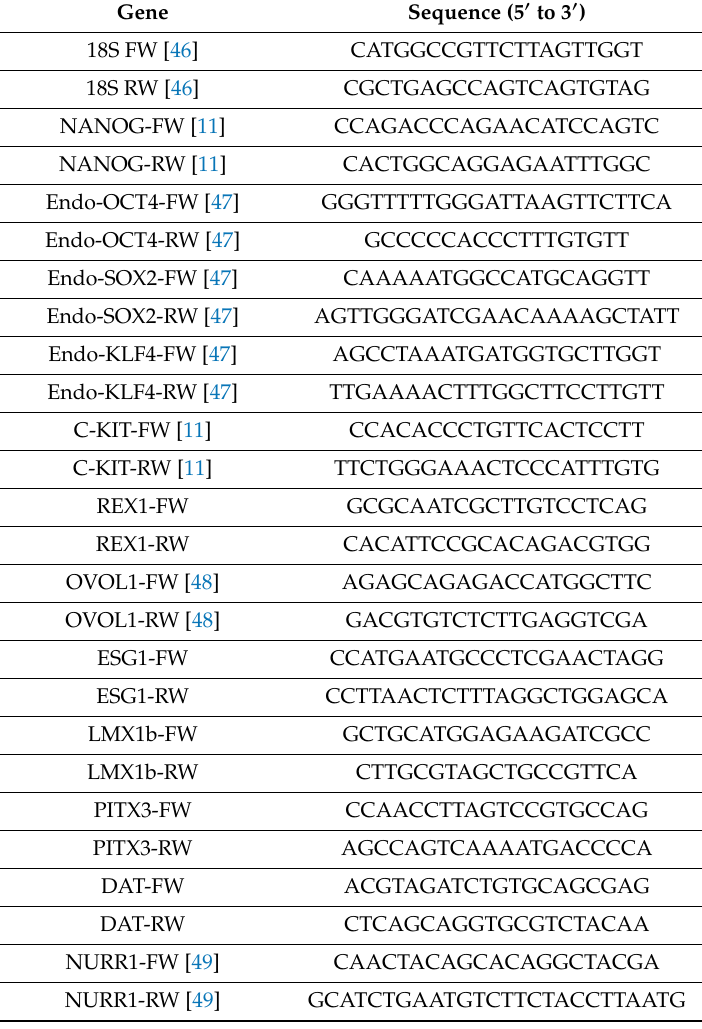
Table 2. Primer sequences for